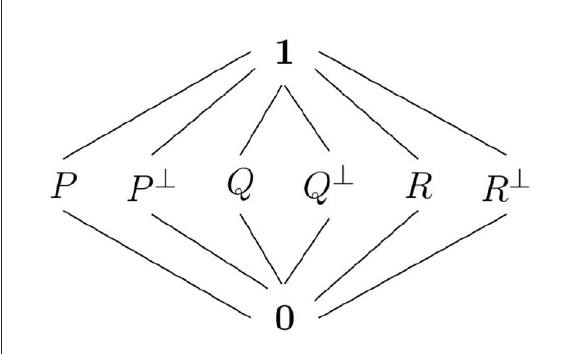
FIGURE3 Hasse diagram of the su (2) projector lattice, known as the non-distributive but modular “Chinese lantern” lattice.